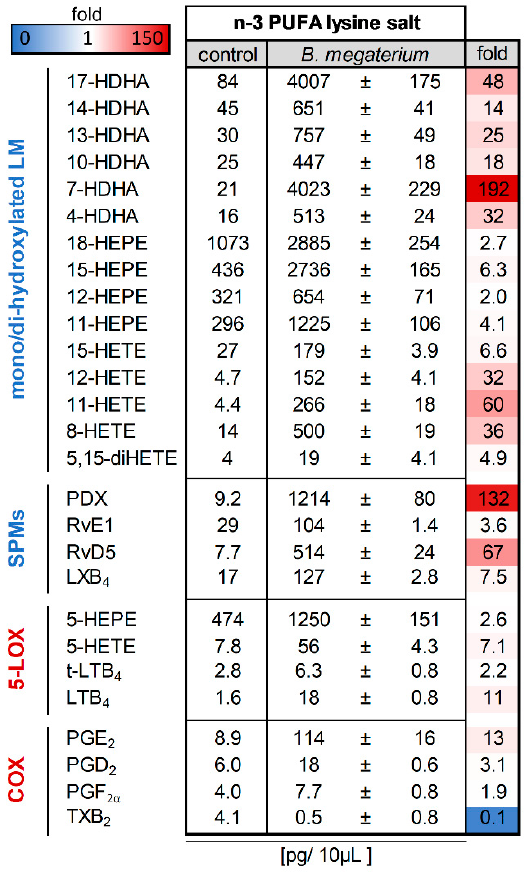
Figure 2. Bacillus megaterium DSM 32963 generates lipid mediators (LM) from n -3 PUFA lysine salt. Probiotic Bacillus megaterium DSM 32963 were cultivated with a liposomal formulation of an n -3 PUFA lysine salt for 17 h; for comparison, n -3 PUFA lysine salt was incubated in parallel without bacteria. Then LM were extracted from the supernatants of these incubations and analyzed for LM by UPLC-MS/MS. The data are given as pg/10 µ L supernatant, mean ± SEM, n = 3 for B. megaterium DSM 32963-treated